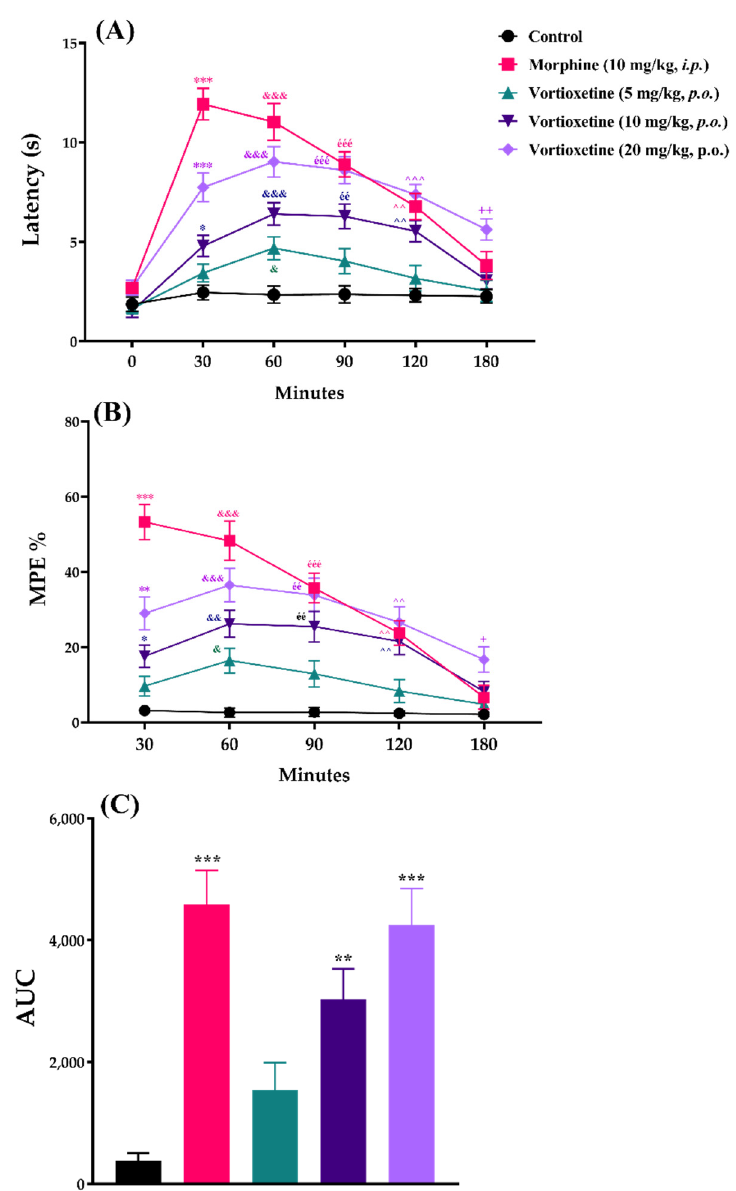
and 5C, respectively.